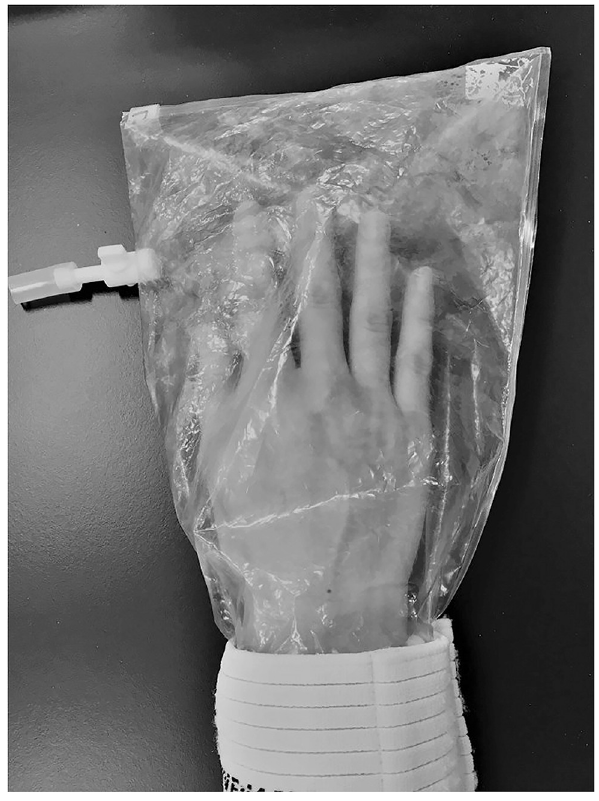
Fig 2. Collection bag for skin gas emanating from subjects’ hands. Hands washed with unscented soap were covered with sampling bags made from a fluorinated ethylene-propylene copolymer material. The air inside was replaced with nitrogen and recovered after a certain